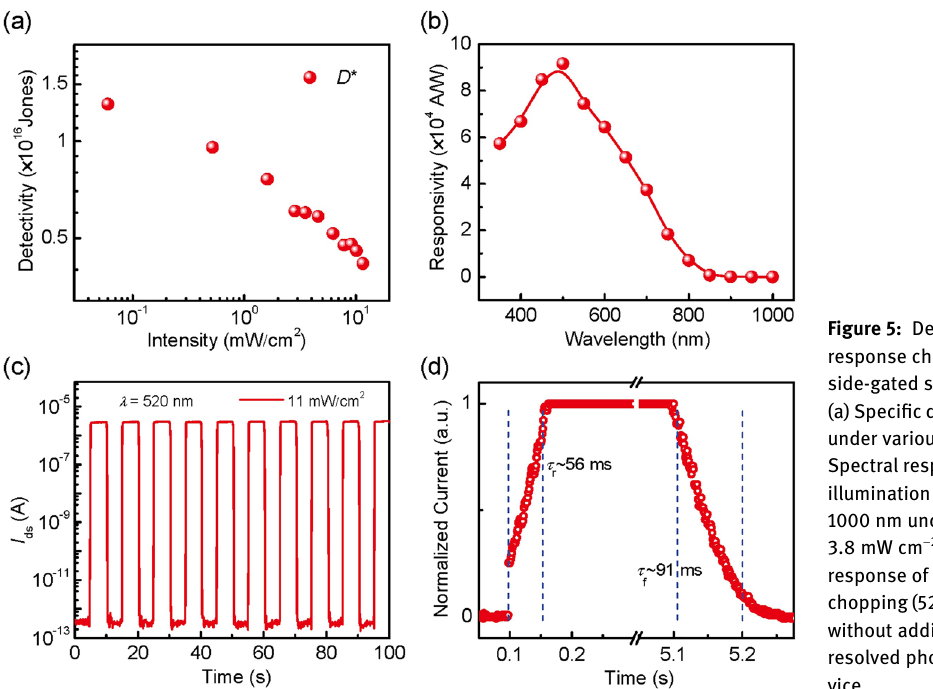
Figure 5: Detectivity, spectral and time response characterizations of ferroelectric side-gated single SnS 2 NW